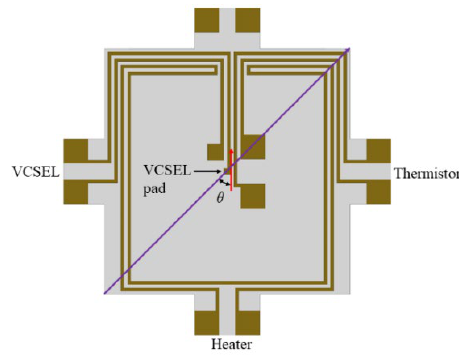
Figure 2. The bottom view of the attenuator. Table 1. Properties of different eutectic solders.